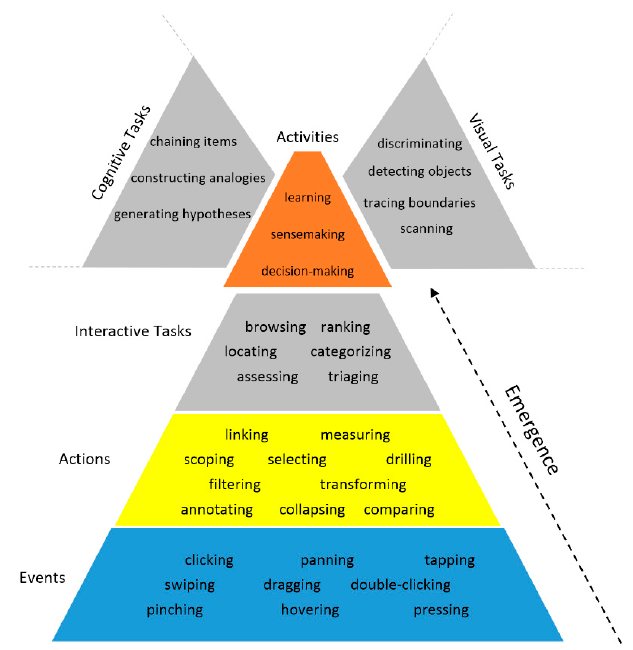
Figure 1. Conceptualization of the human-data discourse.